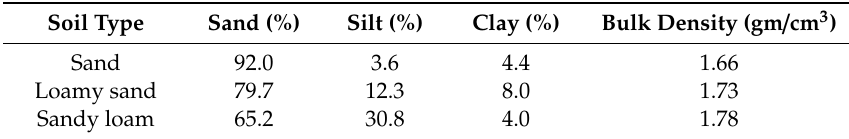
Table 1. Physical properties for the different soil types used in the simulations (Typic Xeropsamments to Typic Psammiaquents).